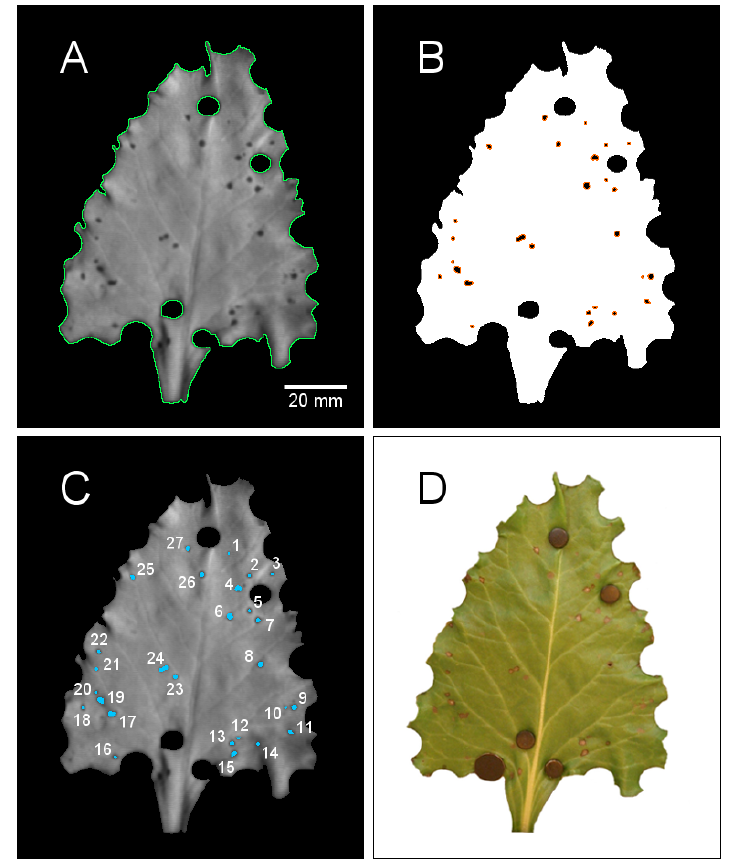
Figure 1. Image analysis of sugar beet leaf spots ( Cercospora beticola ) caused by a natural infection in the field as an example of a general workflow using ImageJ. ( A ) Image of the blue-excited chlorophyll a fluorescence at 689 nm ( 447 F689). The larger circular spots are caused by black disc magnets using to flatten the sugar beet leaf (see also panel D). The leaf margin and the magnets are highlighted by a green line; ( B ) Application of the threshold-function (ImageJ) to the fluorescence image in panel A. The original fluorescence image was converted into a binary image automatically. The orange lines are equivalent to the outer border of the symptoms; ( C ) Visualization (light blue) and labeling of the individual ROIs (regions of interest) at the original fluorescence image ( 447 F689). The used ROI manager-function allows also the saving of the ROIs (disease symptoms) for the further analyzing process; ( D ) Photograph of the infected sugar beet